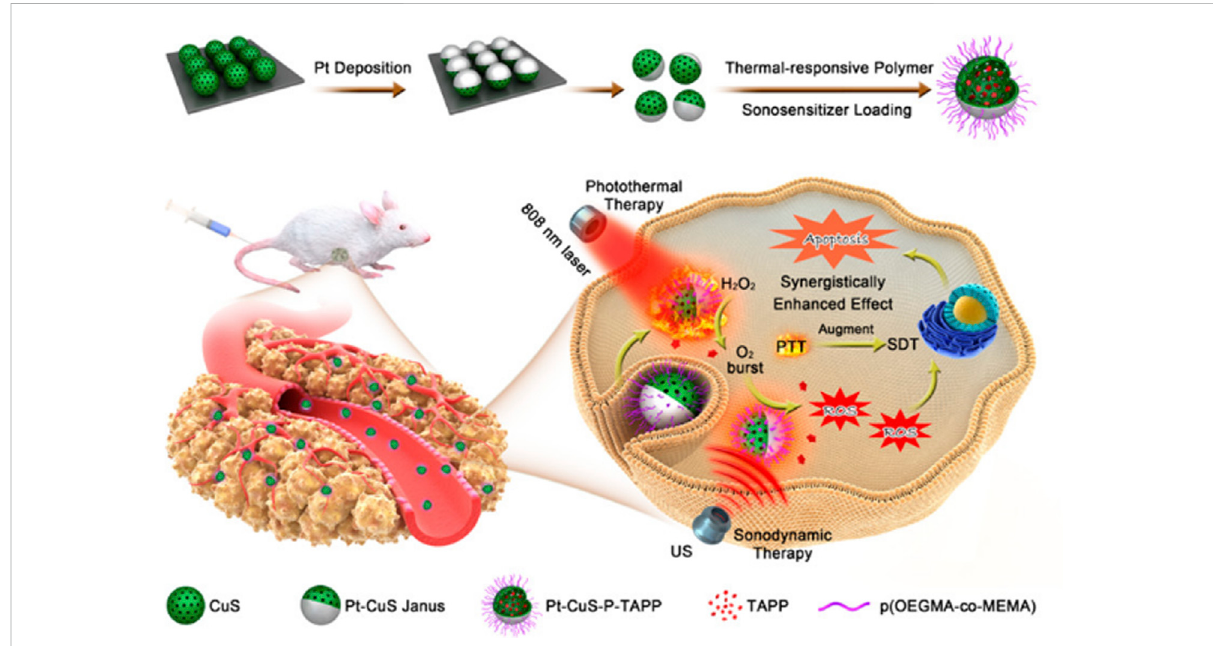
FIGURE 4 Schematic illustration of the main synthesis procedures and antitumor mechanism of PCPT (Liang et al., 2019). Copyright © 2019 American chemical society.